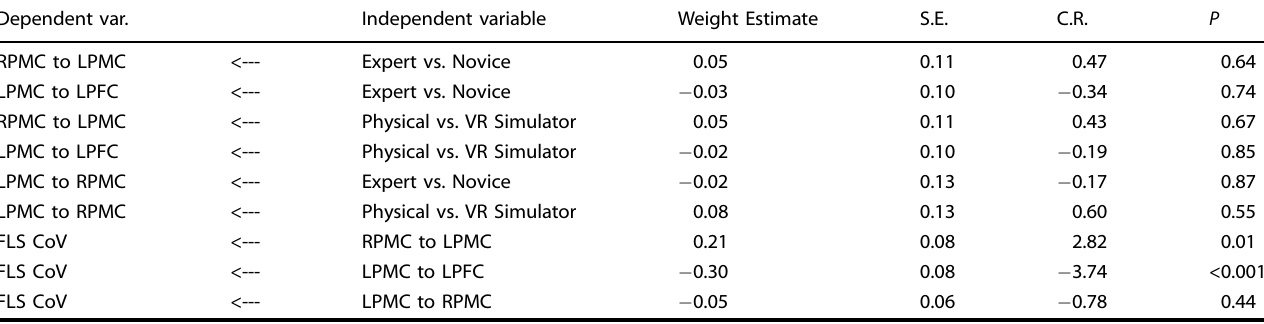
Table 2. Regression weight estimates for path analysis of CoV of the FLS score (grayed rows: signi fi cant after controlling for a false discovery rate of 0.05 with Benjamini – Hochberg